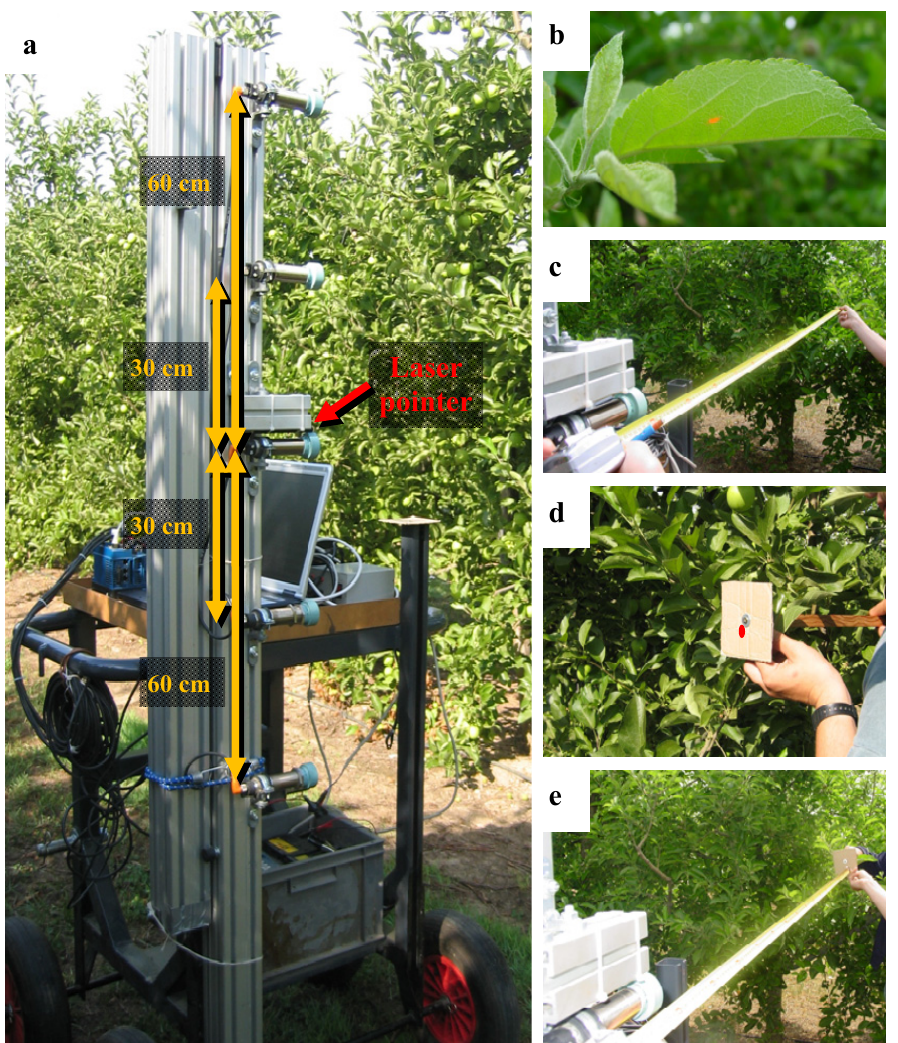
Figure 5. Test platform designed for both the field distance measurement and the interference trials ( a ) and sequence of the procedure for distance assessment ( b , c , d and e